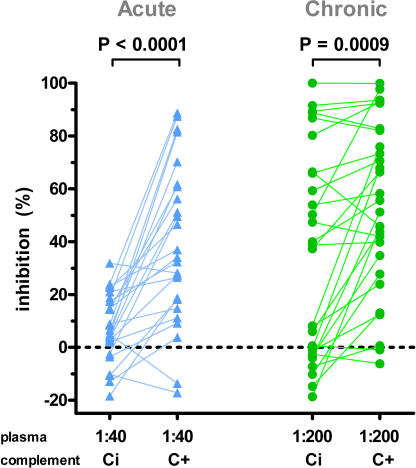
Influence of Complement on Viral Infectivity In VitroInhibitory activity of patient plasma against the heterologous virus JR-FL was measured in presence of active (C+) or heat-inactivated (Ci) complement on TZM-bl cells. Blue triangles denote acutely, green circles chronically infected patients. Data points are means of two independent experiments with plasma from the same patient. Differences in inhibition between inactivated and active complement within the subgroups were compared using Wilcoxon signed-rank test. The results demonstrate that complement increases the inhibitory activity of HIV specific antibodies in vitro.